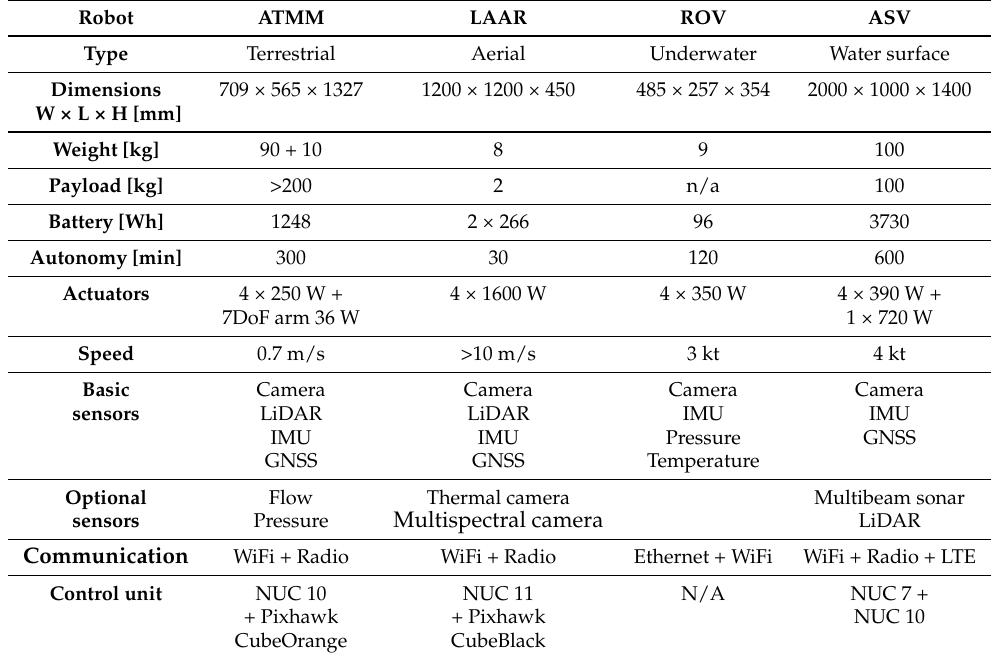
Table 4. Robots of the HEKTOR